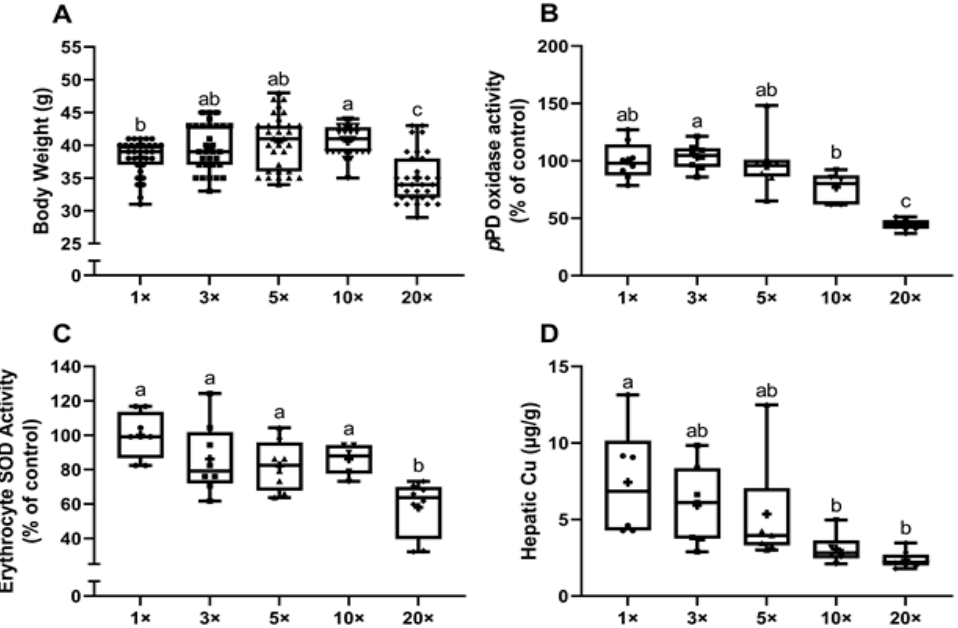
Figure 4. High-iron consumption by rat dams impairs growth, reduces serum p PD oxidase and erythrocyte SOD1 activities, and decreases hepatic copper content in suckling pups. Body weight ( A ), serum p PD oxidase activity ( B ), erythrocyte SOD1 activity ( C ), and hepatic copper concentrations ( D ) were assessed in suckling pups from dams fed diets varying in iron concentration for ~3.5 weeks. One-way ANOVA analysis results are as follows: Body weight ( A ) and p PD oxidase activity ( B ), p < 0.0001; erythrocyte SOD1 activity ( C ), p = 0.0002; hepatic Cu ( D ), p = 0.0051. When statistically significant differences were noted by one-way ANOVA, Tukey’s post hoc test was utilized to make comparisons between individual groups. Values without common superscript letters are statistically different from one another ( p < 0.05 ) ( A–D ). All data points are shown, and the mean values are indicated by “+” signs. For hepatic Cu ( D ), 4 statistical outliers were detected (using the ROUT method, with Q set to 1%) and removed from the dataset.